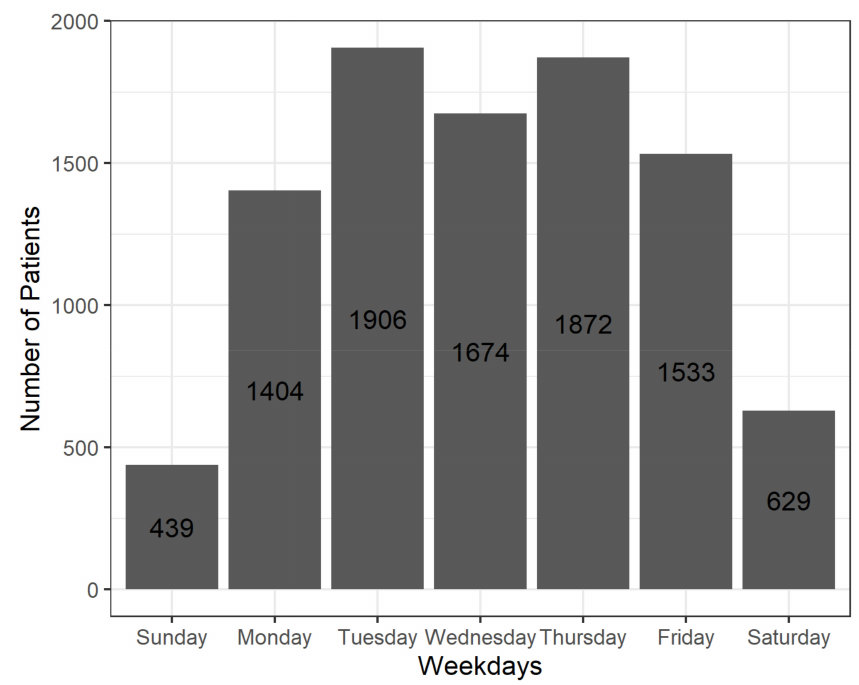
Figure 6. Number of patients, stratified by the day in the week when T 0 was triggered.